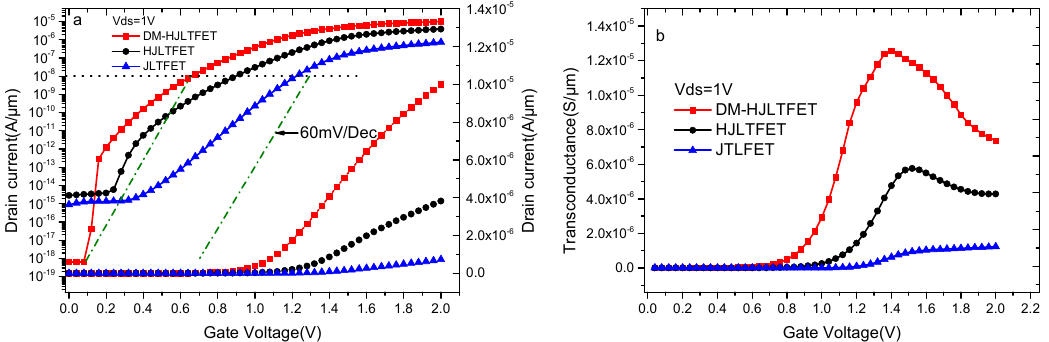
Figure 4. ( a ) The log scale and linear scale transfer characteristics of JLTFET, HJLTFET, and DMMG-HJLTFET; ( b ) transconductance of JLTFET, HJLTFET and DMMG-HJLTFET.